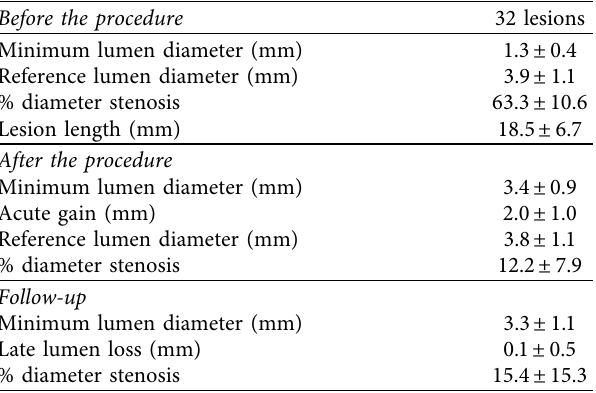
Table 3: Quantitative coronary analysis